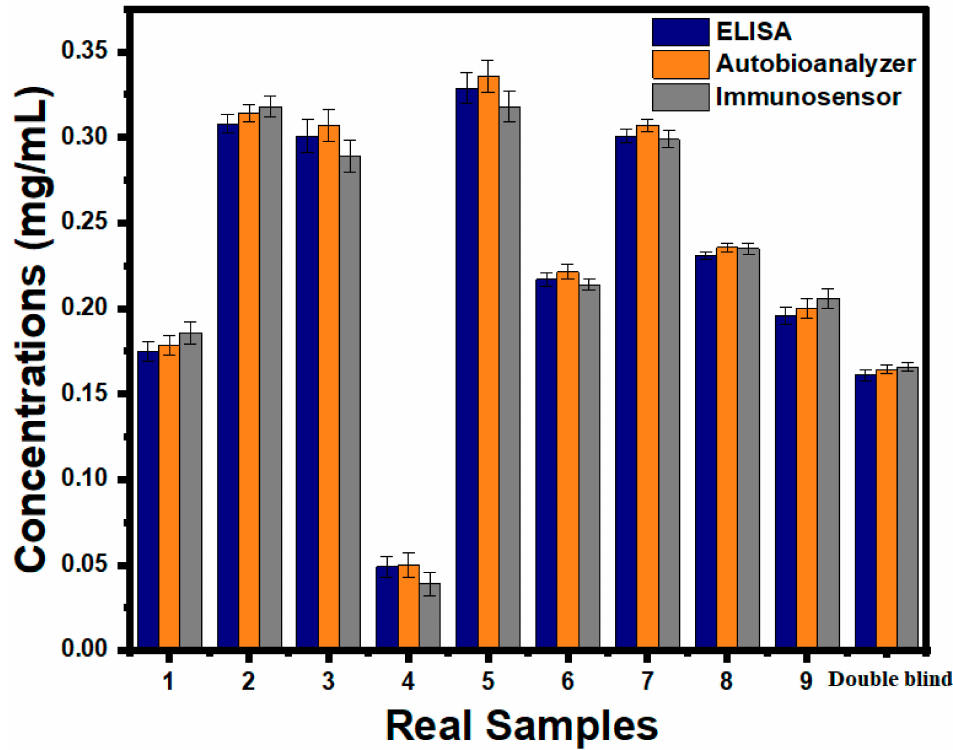
Figure 7. Comparative graph showing the results of the serum sample studies using the anti- Tf/rGO/ITO immunosensor, ELISA, and